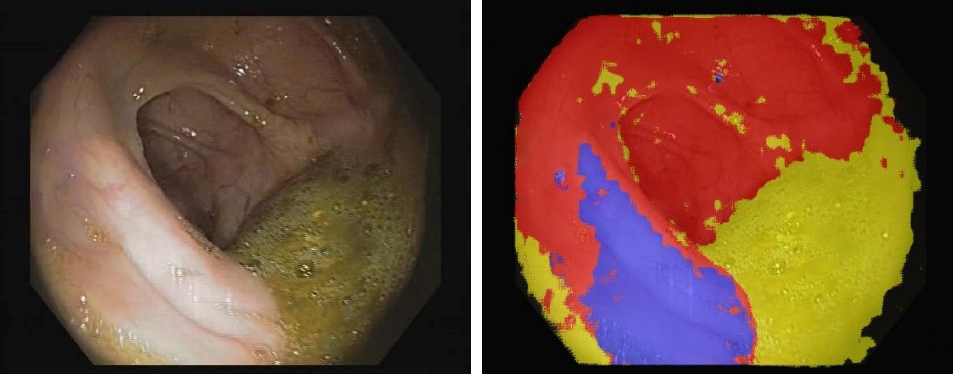
Figure 1. Assigning colors to different components in a colonoscopy frame by deep learning semantic segmentation: mucosa in red, residue in yellow and reflections in blue.